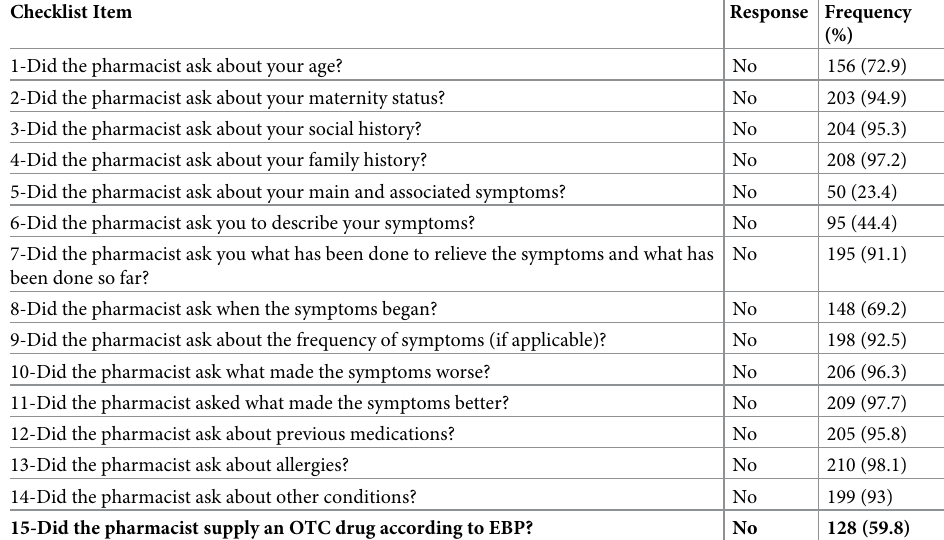
Table 3. Results of the checklist items used to assess responses by pharmacists and the percentage who did not supply OTC medications according to EBPs.